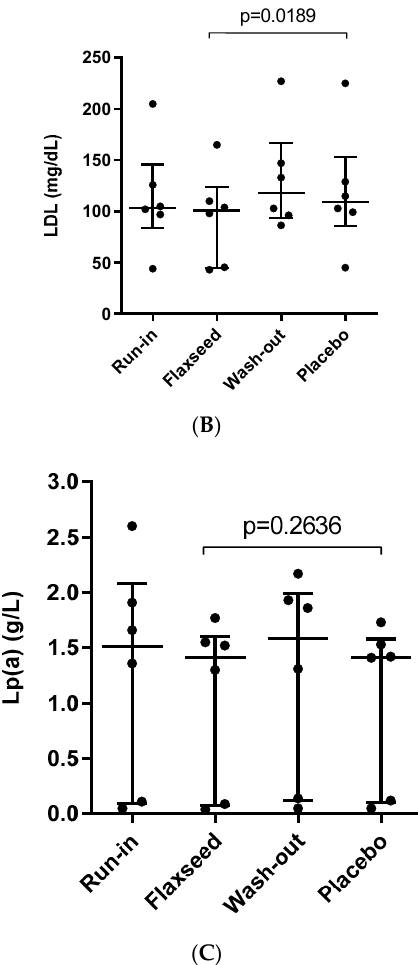
Figure 2. Changes in plasma lipids throughout the study. The concentration of ( A ) total cholesterol; ( B ) LDL; ( C ) Lp(a). The data are given as individual data with medians and ranges indicated, n = 6.